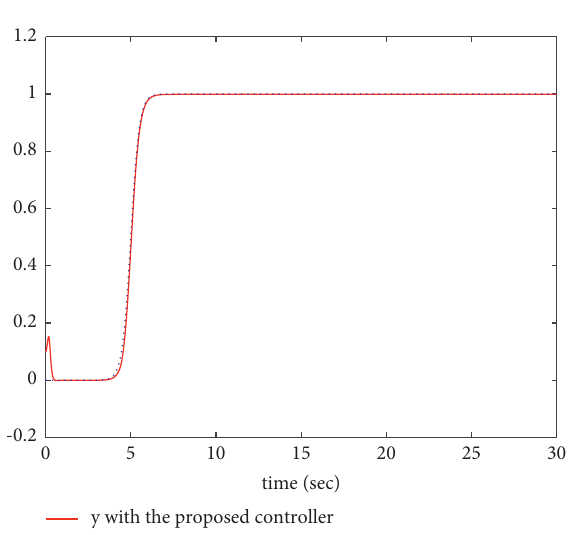
Figure 12: The angle error.